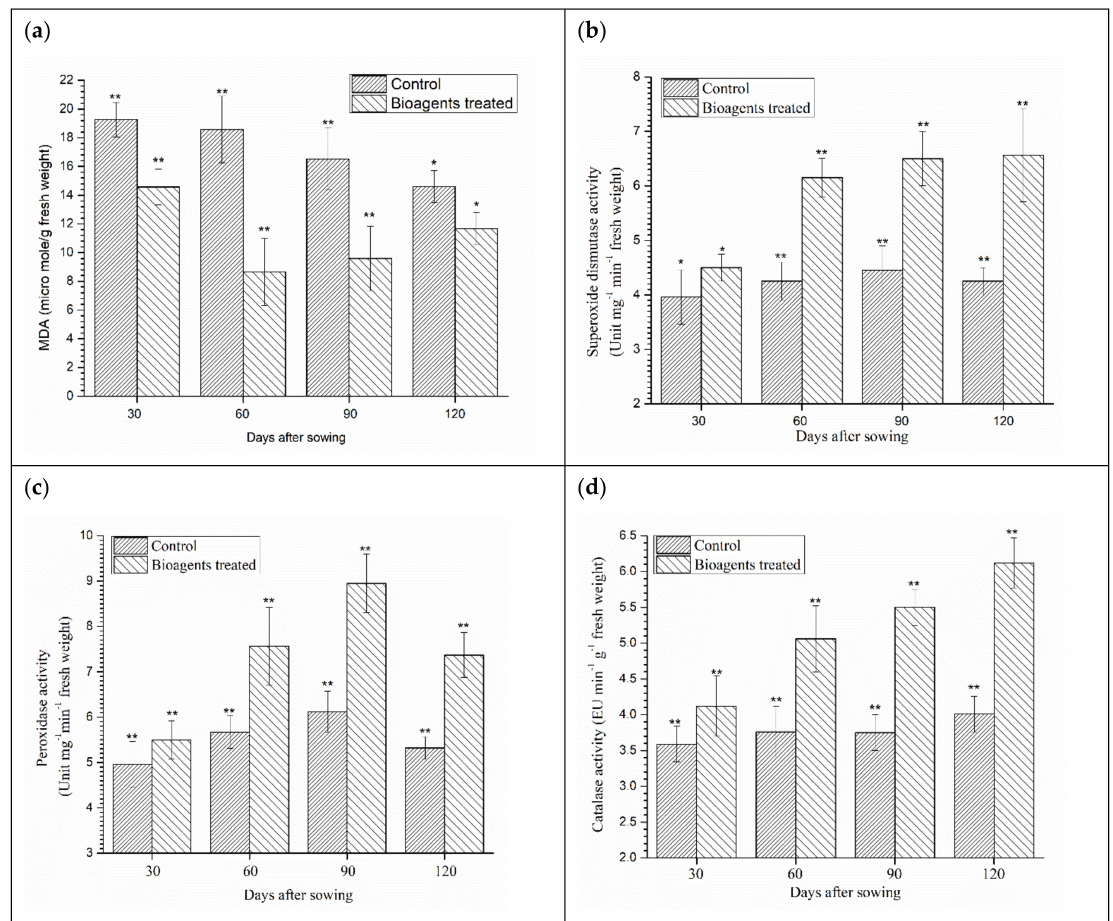
Figure 3. Effect of microbial inoculation on lipid peroxidation and antioxidant enzymes induced in wheat plants grown in saline sodic soil under field condition ( a ) lipid peroxidation (MDA), ( b ) superoxide dismutase, ( c ) peroxidase, and ( d ) catalase activity in wheat plants at 30, 60, 90, 120 DAS. Data are means and vertical bar lines represent standard deviation. Double asterisk (**) represents significant difference, while single asterisk (*) represents non-significant difference with their respective